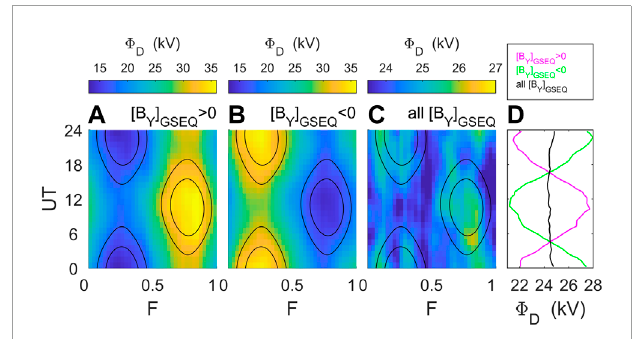
FIGURE 7 The Russell-McPherron effect seen in fraction of year ( F ) - Universal Time ( UT ) plots. The colors in parts (A) , (B) and (C) are the mean predicted magnetopause reconnection voltage Φ D generated using interplanetary data from 1996–2021, inclusive. The black contours are for 95% and 85% of the peak of the predicted IMF orientation factor in Φ D (namely sin 2.5 ( θ / 2 ) , where θ is the IMF clock angle in the GSM frame) for the simplified demonstration of the R-M effect in which the Z-component of the IMF in the GSEQ frame is zero. These contours are computed are for the R-M effect for the two Y-component polarities using an eccentric dipole model for the mid-point date of the data interval (i.e., for 2008). The data are sorted into (A) positive, (B) negative and (C) all [ B Y ] GSEQ . Note that the range of the color scale for part (C) is much smaller than for (A) and (B) . Part (D) shows line-plots of the net UT variations in Φ D , averaged over all F